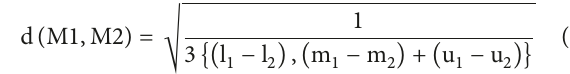
Figure 1: Spindle kick disco